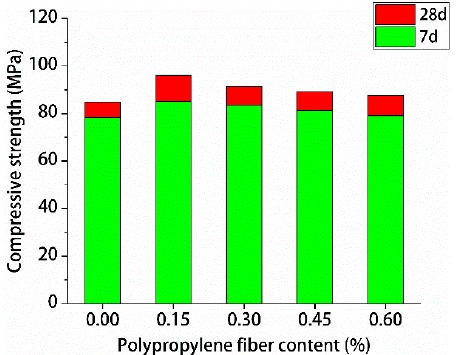
Figure 9. Test results for compressive strength.